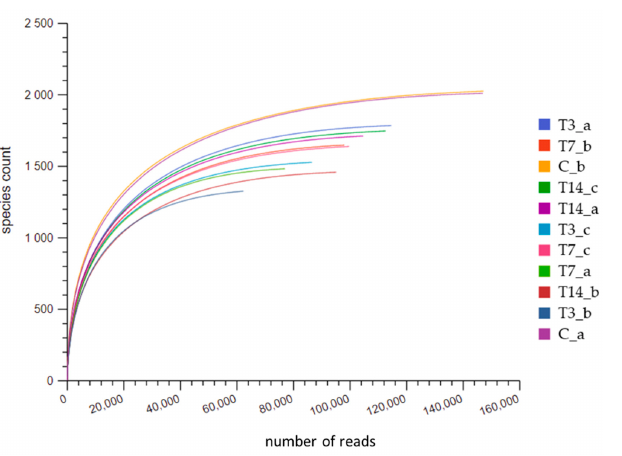
Figure 2. Rarefaction curves relative to the number of sequences and OTUs associated with each soil sample. C are the control unheated samples; T3, T7, T14 are the thermally treated samples after 3, 7 and 14 days of incubation, respectively; a, b, c are the replicates.